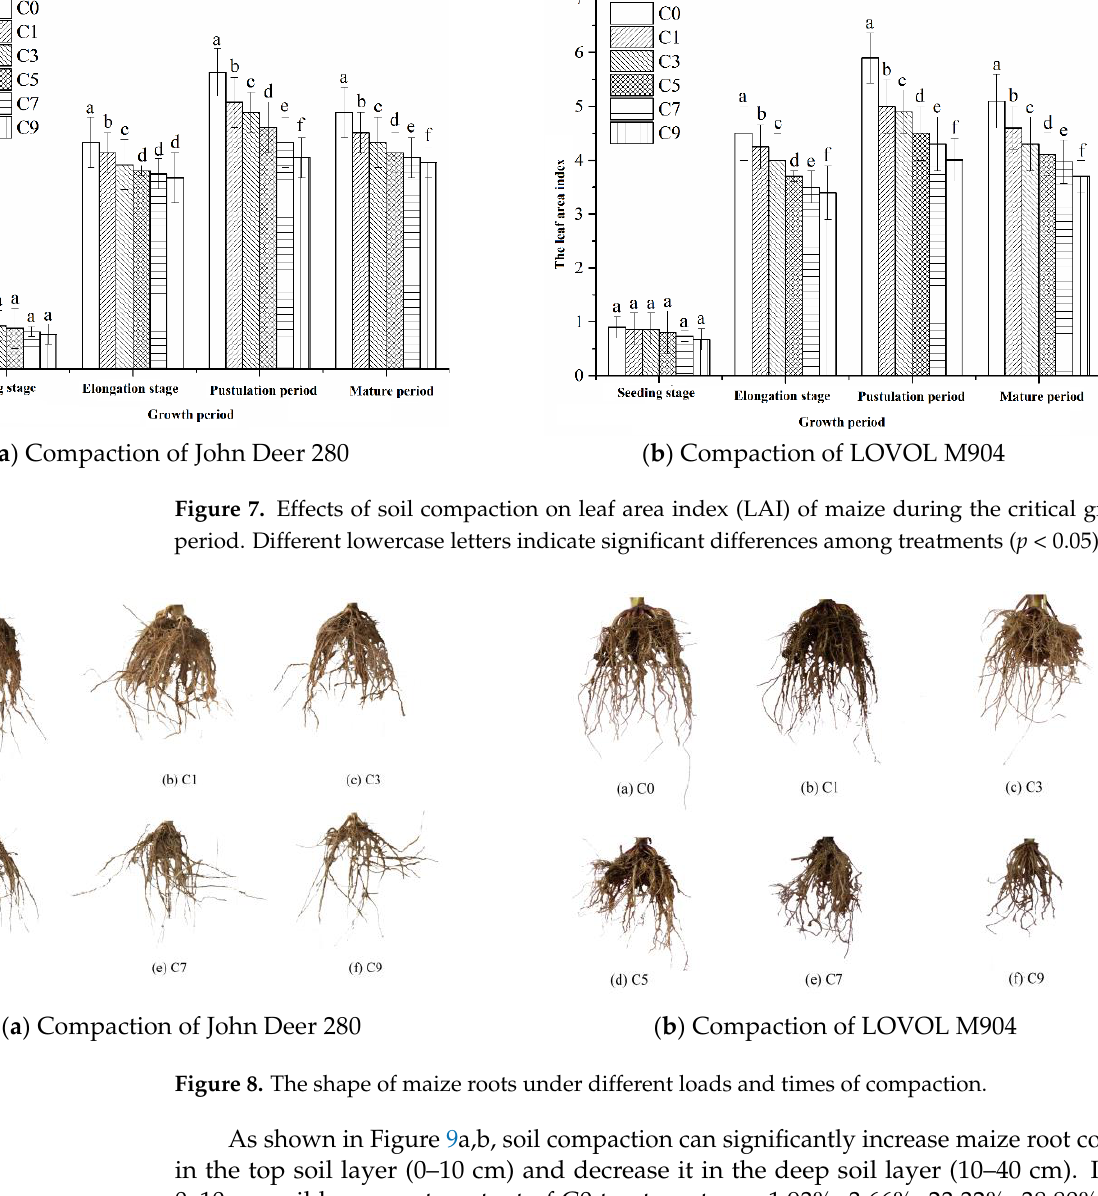
Figure 8. The shape of maize roots under different loads and times of compaction.